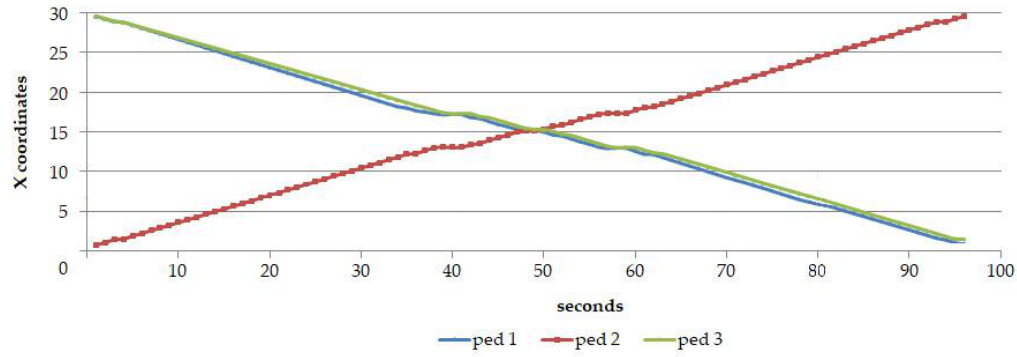
Figure 3. Trajectories of pedestrians considering Viswalk trajectories output.